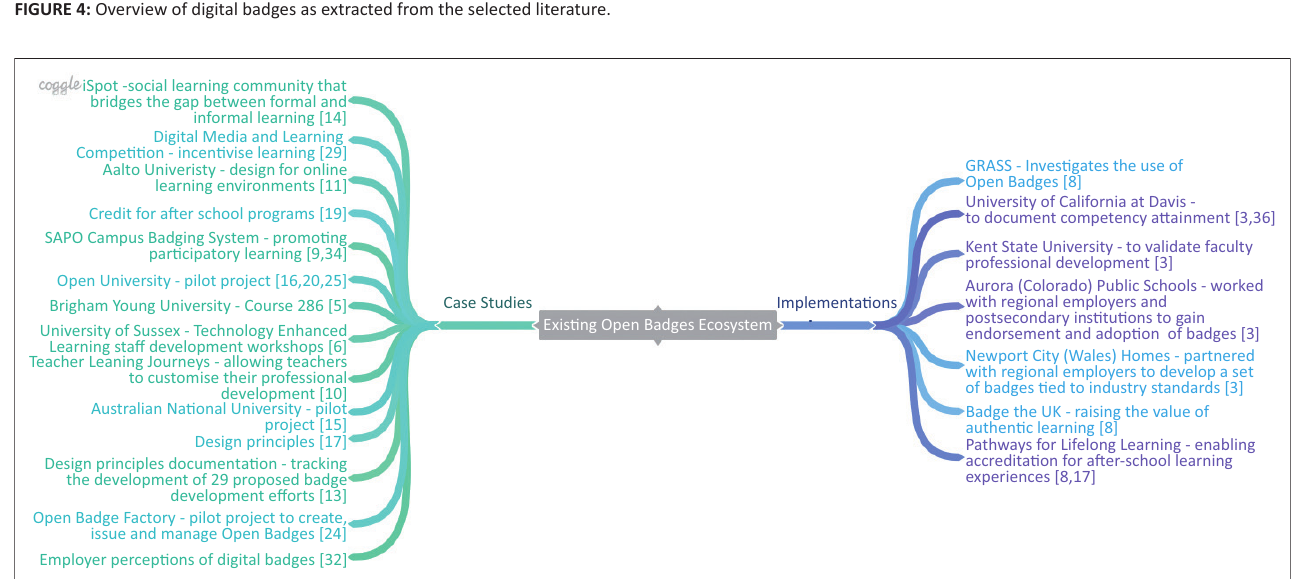
FIGURE 5: Literature linked to case studies and